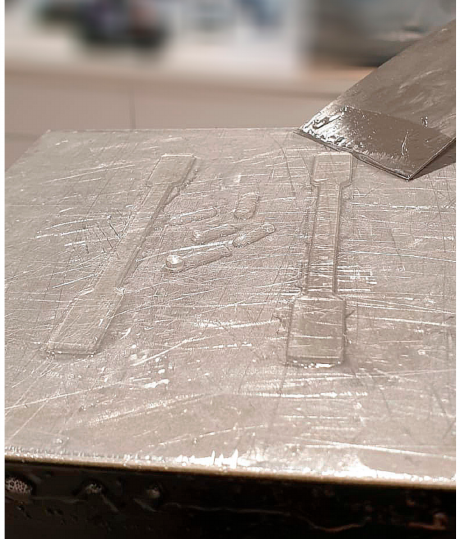
Figure 4. Three-dimensional printed samples of bars (specimens) for determination of the mechanical properties of Dental LT ClearResin. Specimens were printed directly on printing plate without any supports and then carefully removed and